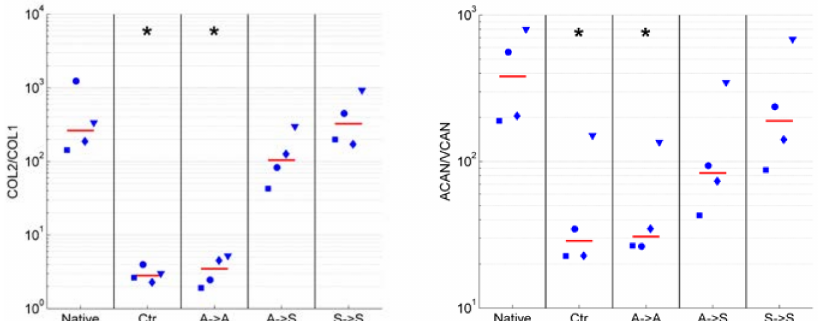
Figure 4. Chondrocyte dedifferentiation marker. The degree of dedifferentiation was quantified by the mRNA expression ratios of collagen type II to type I ( COL2 / COL1 ; left ) and aggrecan to versican ( ACAN / VCAN ; right ). High values of these ratios indicate differentiated chondrocytes, whereas low values indicate dedifferentiated cells. The ratios COL2 / COL1 and ACAN / VCAN were reduced in adherent cells (Ctr and A->A) and remained high in suspended cells (A->S and S->S). The blue markers indicate the individual values of the four unique animals (unique shape for each animal), and the red line indicates the median from all of the experiments. The asterisks indicate statistically significant difference as compared to the native cells. The nomenclature of the samples is indicated in Figure 1.